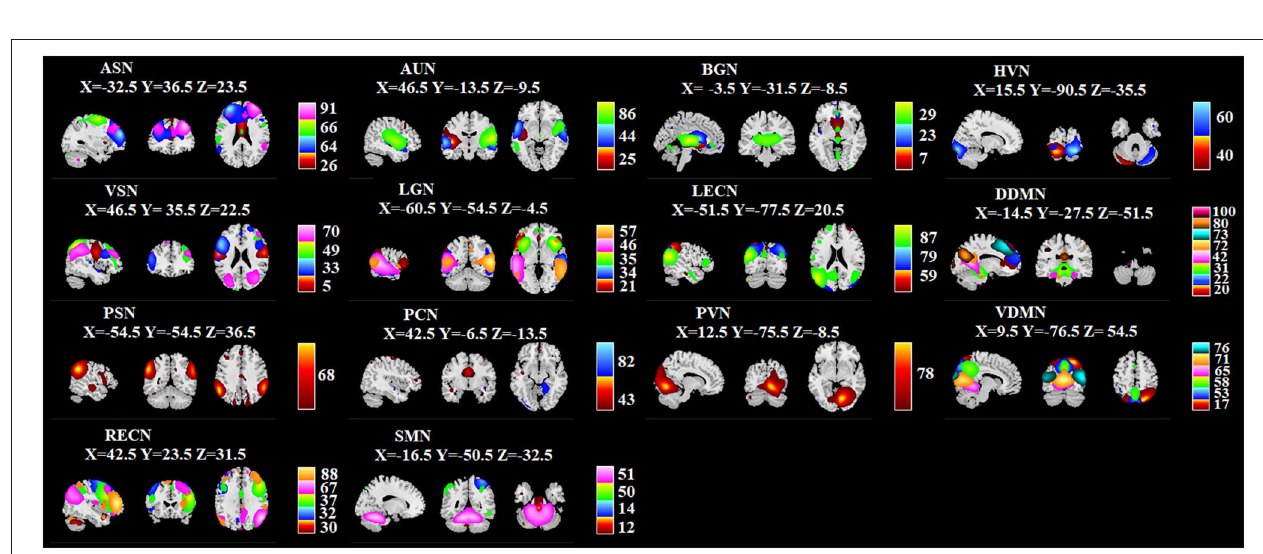
FIGURE 6 | Identified ICs. Within each ICN, the color of the component corresponds to No. of ICs. X, Y, Z corresponds to the MNI coordinates.